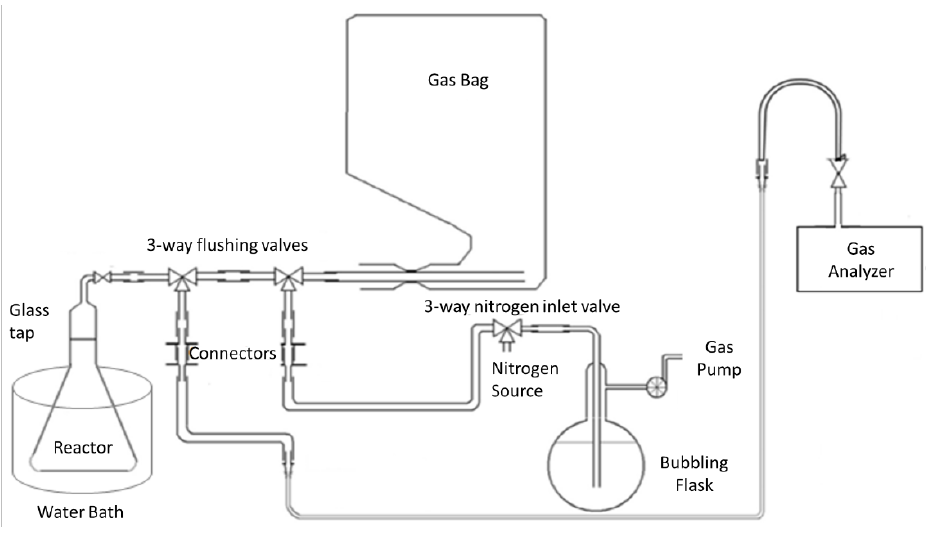
Figure 1. Bioreactor set up .